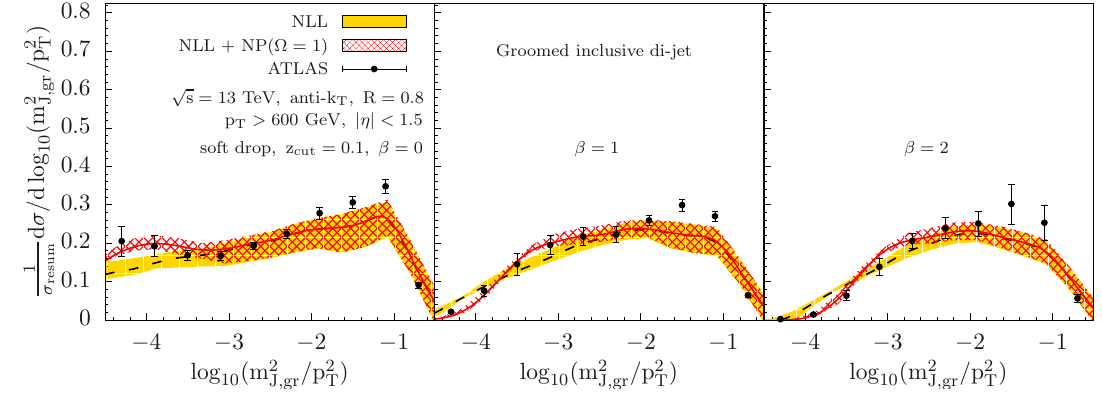
Figure 9 . Comparison of our theoretical calculations and the experimental data from the ATLAS collaboration [48] for the soft drop groomed jet mass distribution in pp collisions at p s = 13 TeV at the LHC. See text for a more detailed